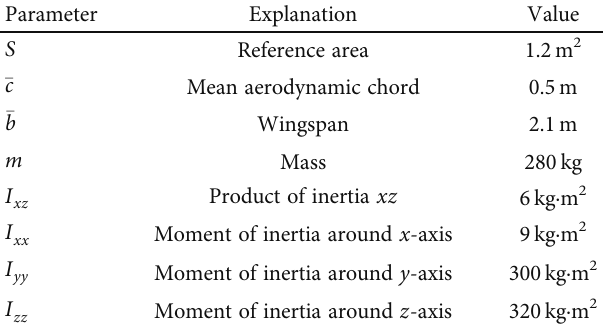
Table 1: General properties of the research LSR aircraft. Parameter